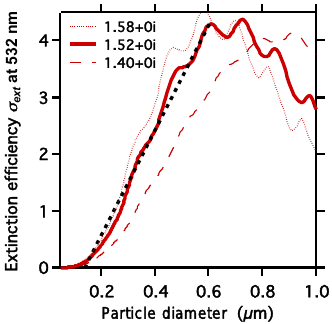
Figure A1. Calculated extinction efficiency for a particle with a refractive index of 1.52 + 0 i (solid line) and linear least-squares fit for 0.1 <D p < 0.6 (dashed line). The extinction efficiency av- eraged across the size range of hygroscopic growth of a typical accumulation-mode aerosol is approximately linear. Extinction ef- ficiency curves for 1.58 + 0 i and 1.40 + 0 i are also